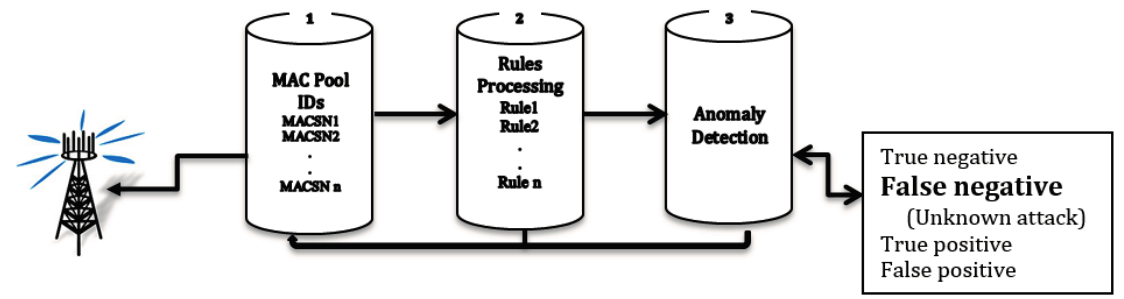
Figure 2. Multi-Layers in Rules-Based